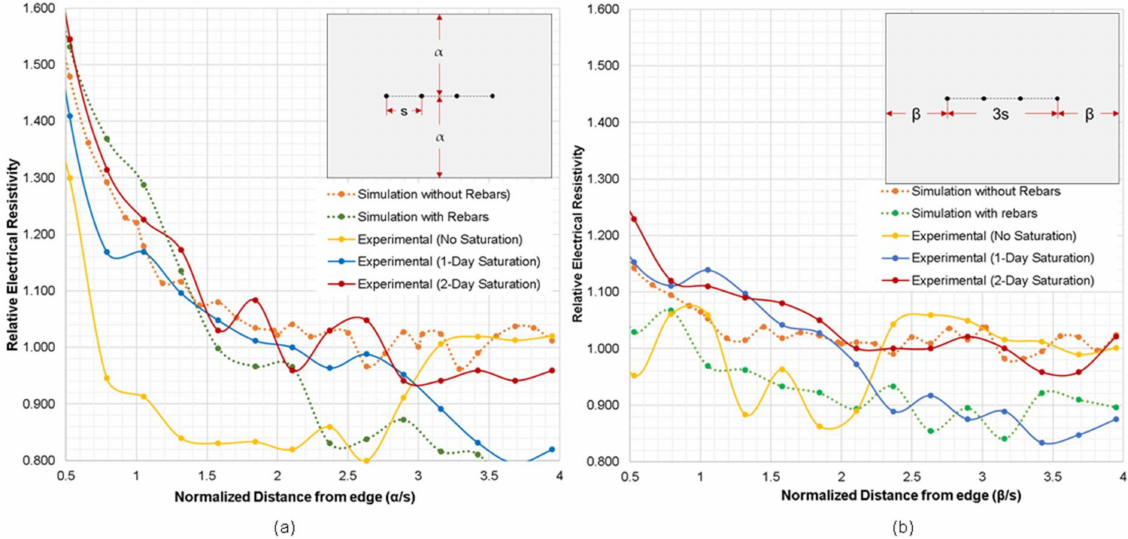
Figure 9. Numerical and experimental relative electrical resistivity of concrete slab with respect to the normalized distance from edge of slab, where ( a ) probes are parallel to edge of slab, and ( b ) probes are perpendicular to slab